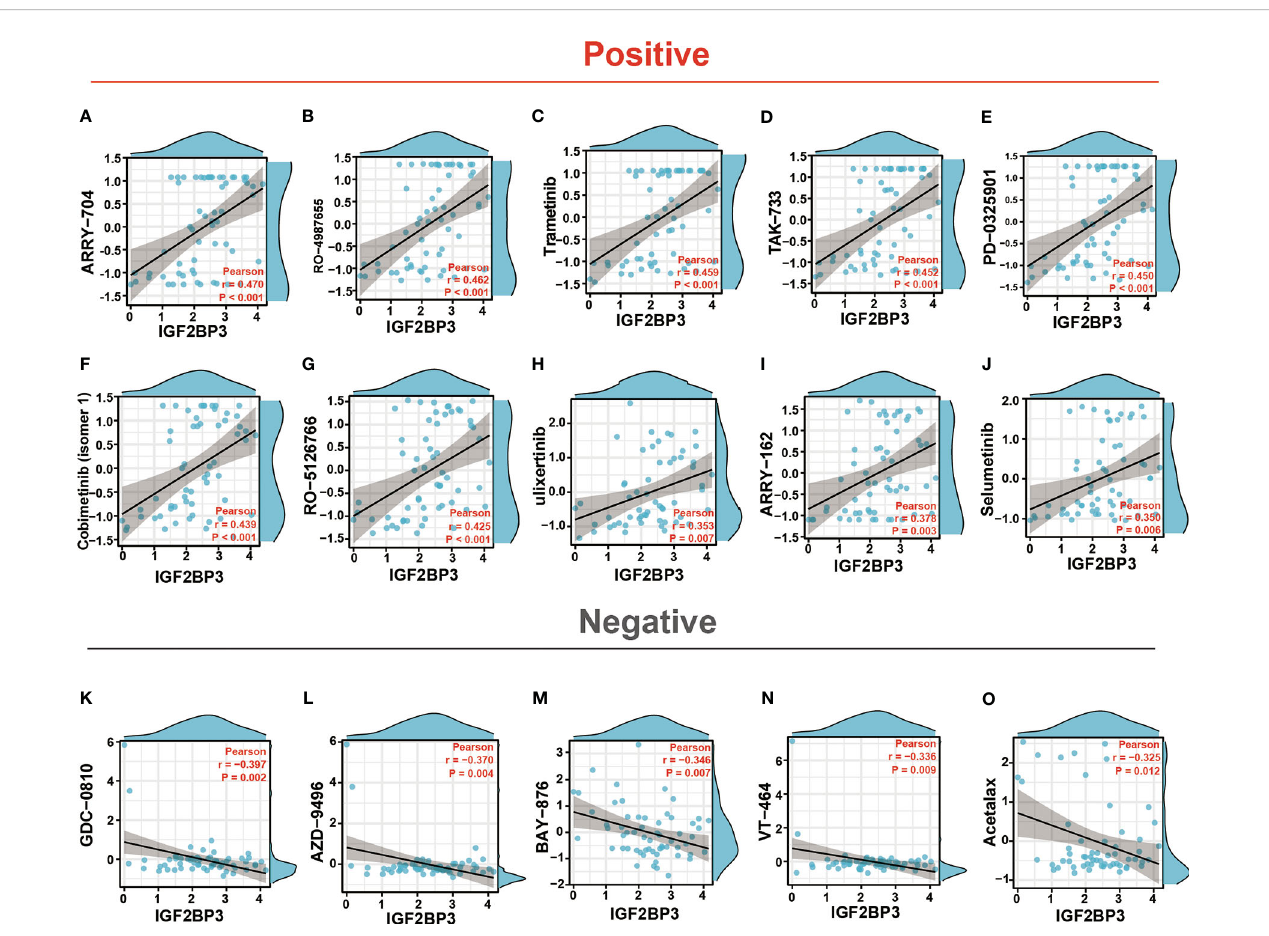
FIGURE 13 Drug sensitivity analysis of IGF2BP3. The expression of IGF2BP3 was associated with the sensitivity of ARRY-704 (A) , RO-4987655 (B) , Trametinib (C) , TAK-733 (D) , PD-0325901 (E) , Cobimetinib (isomer1) (F) , RO-5126766 (G) , Ulixertinib (H) , ARRY-162 (I) , Selumetinib (J) , GDC-0810 (K) , AZD-9496 (L) , BAY-876 (M) , VT-464 (N) , and Acetalax sensitivity (O)